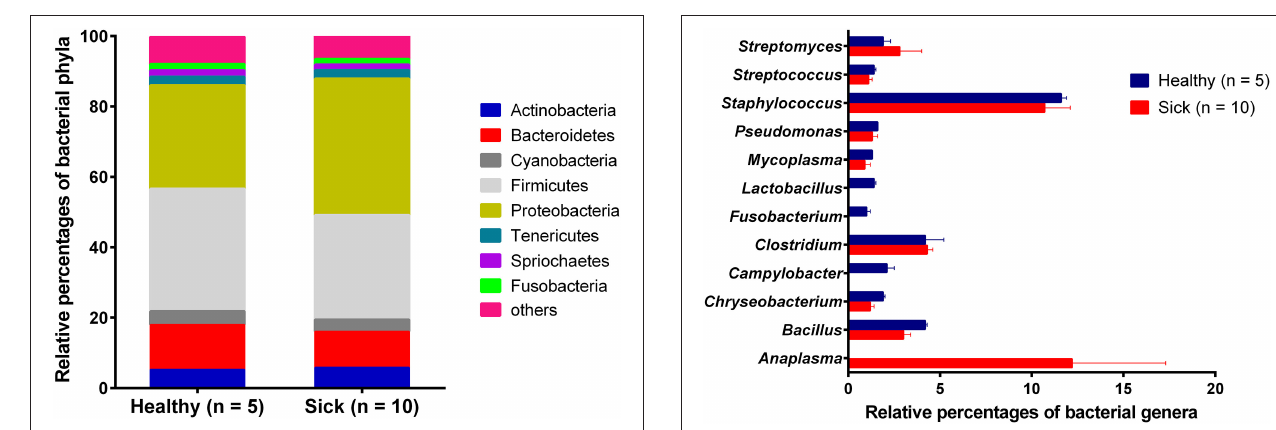
FIGURE 1 | Relative abundance of circulating bacterial phyla reads from horses with suspected tick-borne infection (sick) and apparently healthy animals. The percentages were estimated out of total bacterial reads.